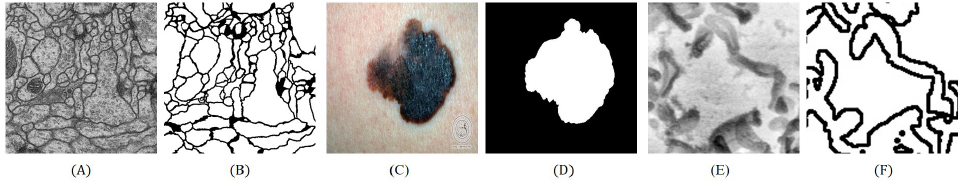
Figure 2. Sample of an unlabeled image and GT label of the ( A , B ) EM dataset ( C , D ) melanoma dataset and ( E , F ) biofilm